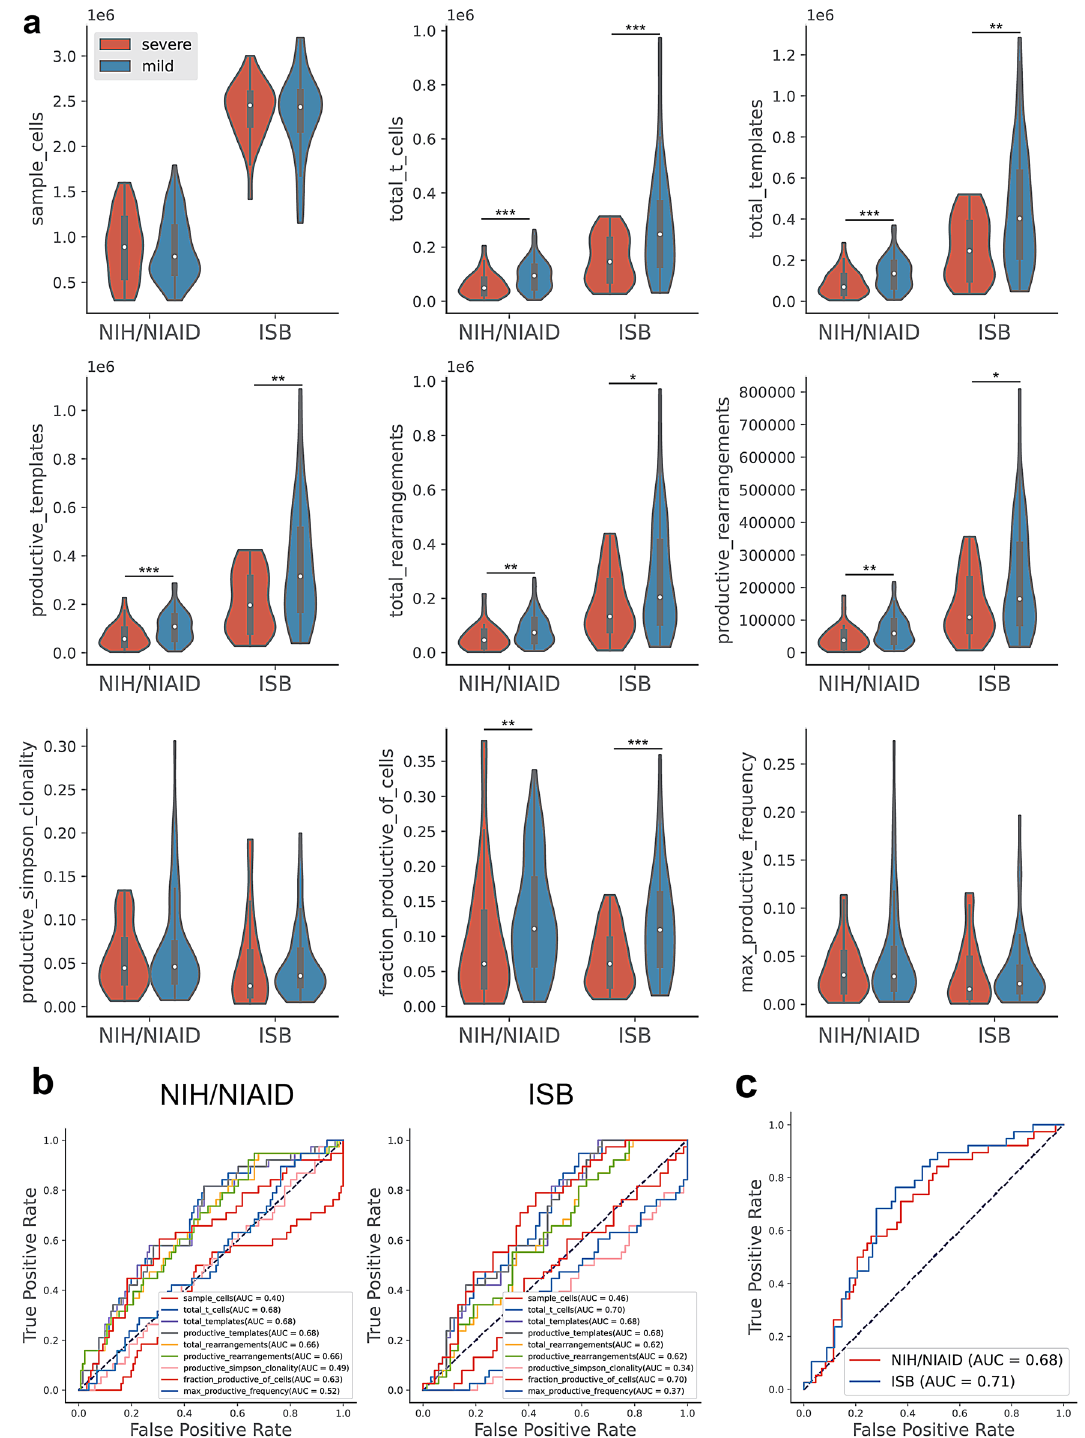
Figure 1. Associations of TCR diversity and abundance metrics to disease severity. ( a ) TCR-Seq diversity and abundance metrics were collected and stratified by disease severity in both the COVID-19-ISB and COVID-19-NIH/NIAID cohorts. (Mann–Whitney rank test: *** p val < 0.001, ** p val < 0.01, * p val < 0.05, with multiple hypothesis testing with Benjamini/Hochberg correction, α = 0.05). ( b ) Uni-variate logistic regression models were fit on all TCR-Seq sample-level measures and performance was assessed via receiving operating characteristic (ROC) curves and calculating area under the curve (AUC) with 2-fold cross-validation with 100 iterations, averaging predictions across all iterations and folds. ( c ) Multi-variate logistic regression models were fit on all TCR-Seq sample-level measures and performance was assessed in the same manner as previously described in ( b